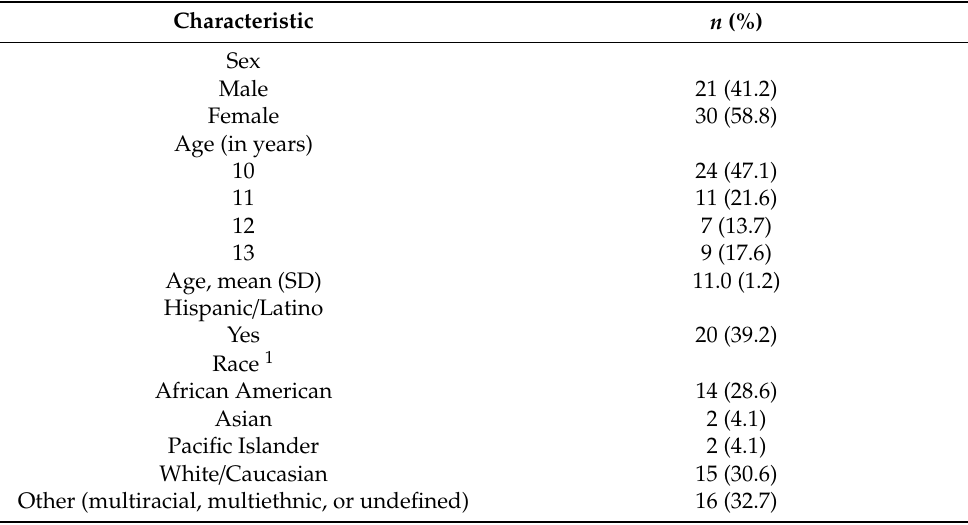
Table 2. Demographic characteristics of participants (10–13 years).